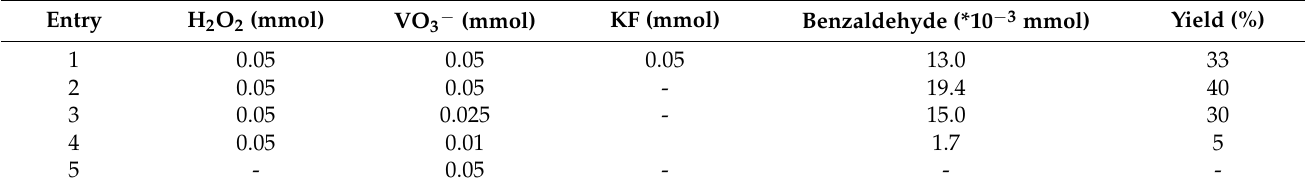
Table 5. Toluene oxidation in biphasic system (V = 20 mL; PhCH 3 :H 2 O 1:1 v/v ), pH = 1, 24 h, T = 25 ◦ C, O 2 .